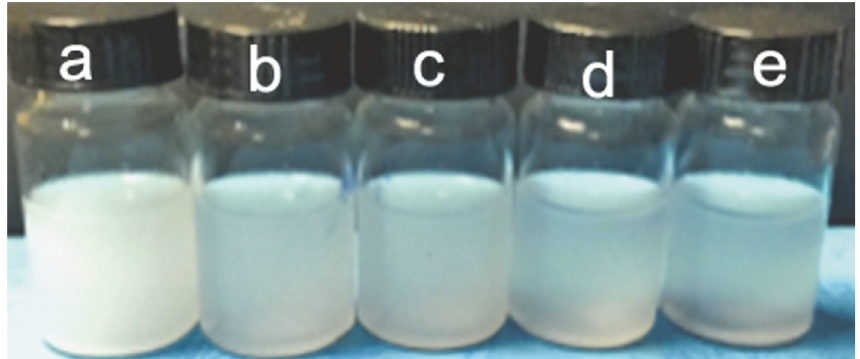
Figure 3: Photos of the RC dispersions (a) and SRC with different contents of sulphurous acid groups; (b)-(e) were for SRC-10, SRC-30, SRC-40, SRC-50, respectively.